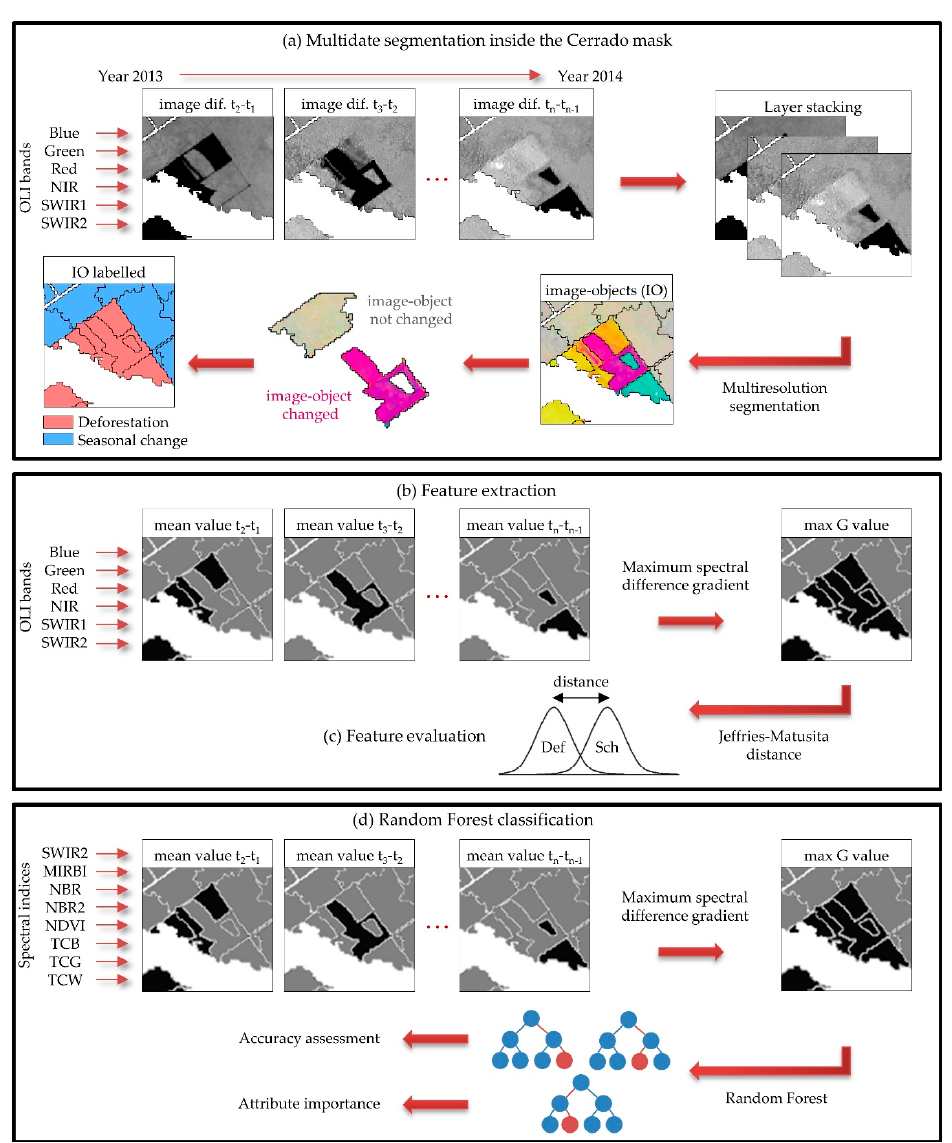
Figure 2. Schematic illustrating the change detection method. (a) Segmentation of multitemporal image objects; (b) Extraction of the maximum spectral difference gradient value; (c) Evaluation of OLI bands to separate deforestation from seasonal changes; (d) Random Forest classification of the image objects.